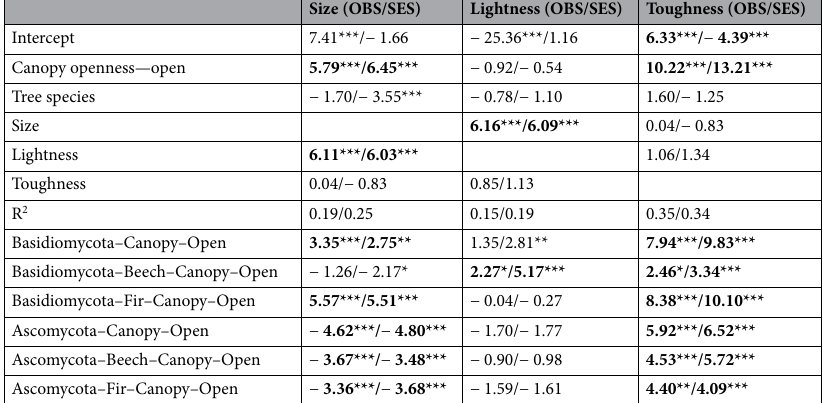
Table 1. Linear mixed-effects model of the effect of canopy openness on observed community fruit body traits. We first tested the effect of the main predictor, canopy openness, on the full community. We then tested the interaction between lineages and canopy; and between lineages, tree species, and canopy. Effect sizes (z values) are displayed for the linear mixed models with a random effect ‘plot in block’. On the left side of each column, the effects of the observed community trait are shown. On the right, the effects for the standardized community trait are based on a null model. Significances are indicated by asterisks, where ‘*’ corresponds to p < 0.05, ‘**’ to p < 0.01 and ‘***’ to p < 0.001. Significant effects were highlighted in bold if both the observed community mean and the standardized effect size (SES) of the community traits were significant. The coefficient of determination is given as marginal R 2